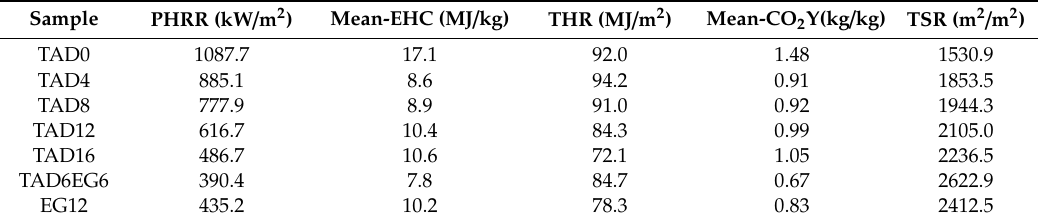
Figure 2. Heat release rate (HRR) curves of PBT/PET blend and different flame-retardant PBT/PET materials. Table 2. Cone calorimeter test results of PBT/PET blend and flame-retardant PBT/PET materials.